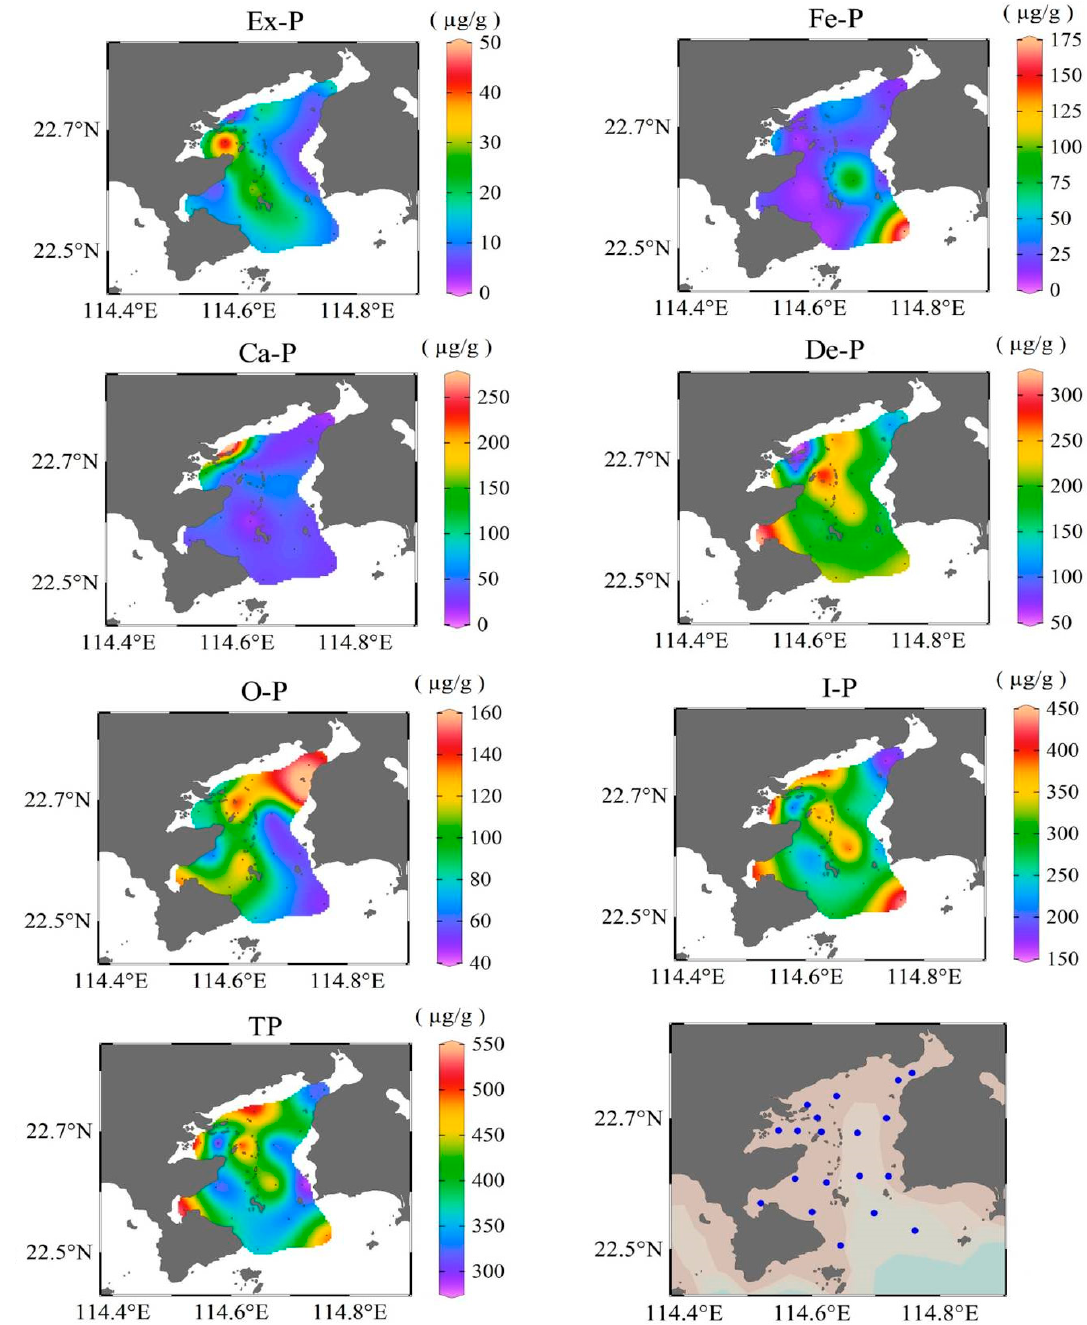
Figure 3. Spatial distributions of different P fractions in the sediment of Daya Bay, China.